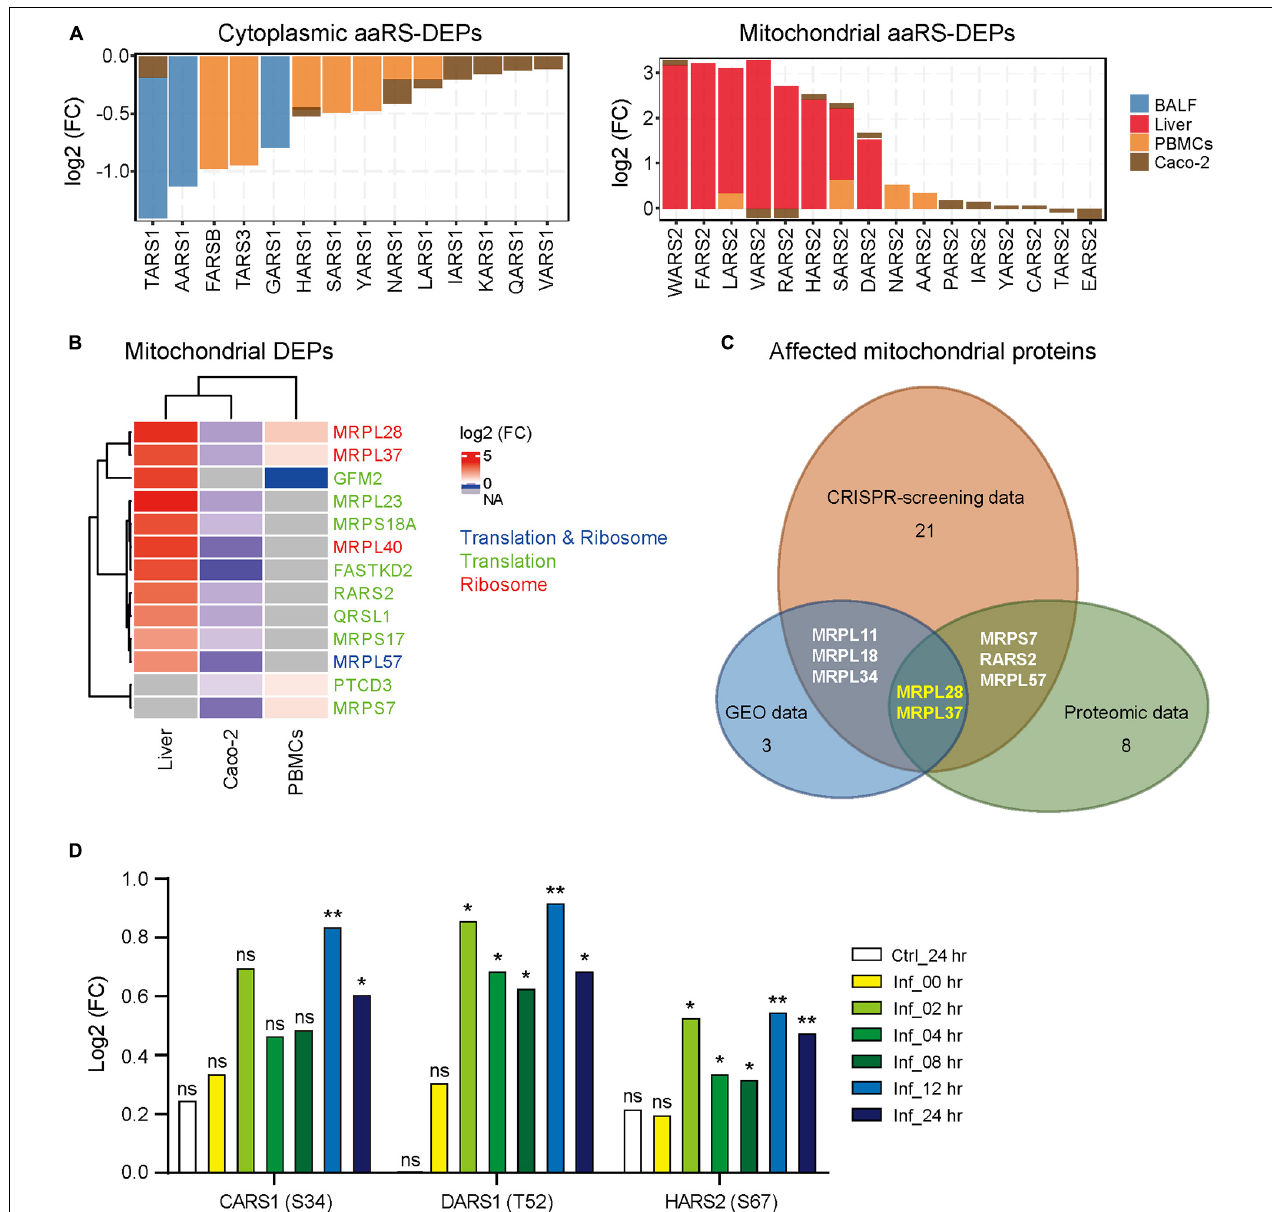
FIGURE 3 | Protein profile and phosphorylated modification of aminoacyl-tRNA synthetases (aaRSs) upon SARS-CoV-2 infection. (A) Protein levels of aaRS-DEPs (with the cyto-aaRSs on the left and the mt-aaRSs on the right) in BALF, liver cells and PBMCs from coronavirus disease 2019 (COVID-19) patients, as well as in Caco-2 cells infected with SARS-CoV-2. (B) Heatmap of mitochondrial translation- and ribosome-related DEPs from different samples. The fold change in protein expression is indicated by color intensity, with red representing the upregulated DEPs and blue representing the downregulated DEPs. The DEPs include translation- and ribosome-related proteins (blue), translation-related proteins (green), and ribosome-related proteins (red). (C) Wayne diagram of the affected mitochondrial translation- and ribosome-related genes and proteins across CRISPR-screening, gene expression omnibus (GEO), and proteomic data. Genes with significant Z scores upon SARS-CoV-2 infection, mitochondrial DEGs and DEPs were included for analysis. The remaining number of the affected mitochondrial proteins in each platform is indicated except for the overlapping ones. (D) Phosphorylation of aaRSs (phosphorylated site) at different indicated time. Ctrl, control; Inf, infection; hr, hour; ns, not significant; * p < 0.05; ** p < 0.01 (vs. mock-infected cells at 0